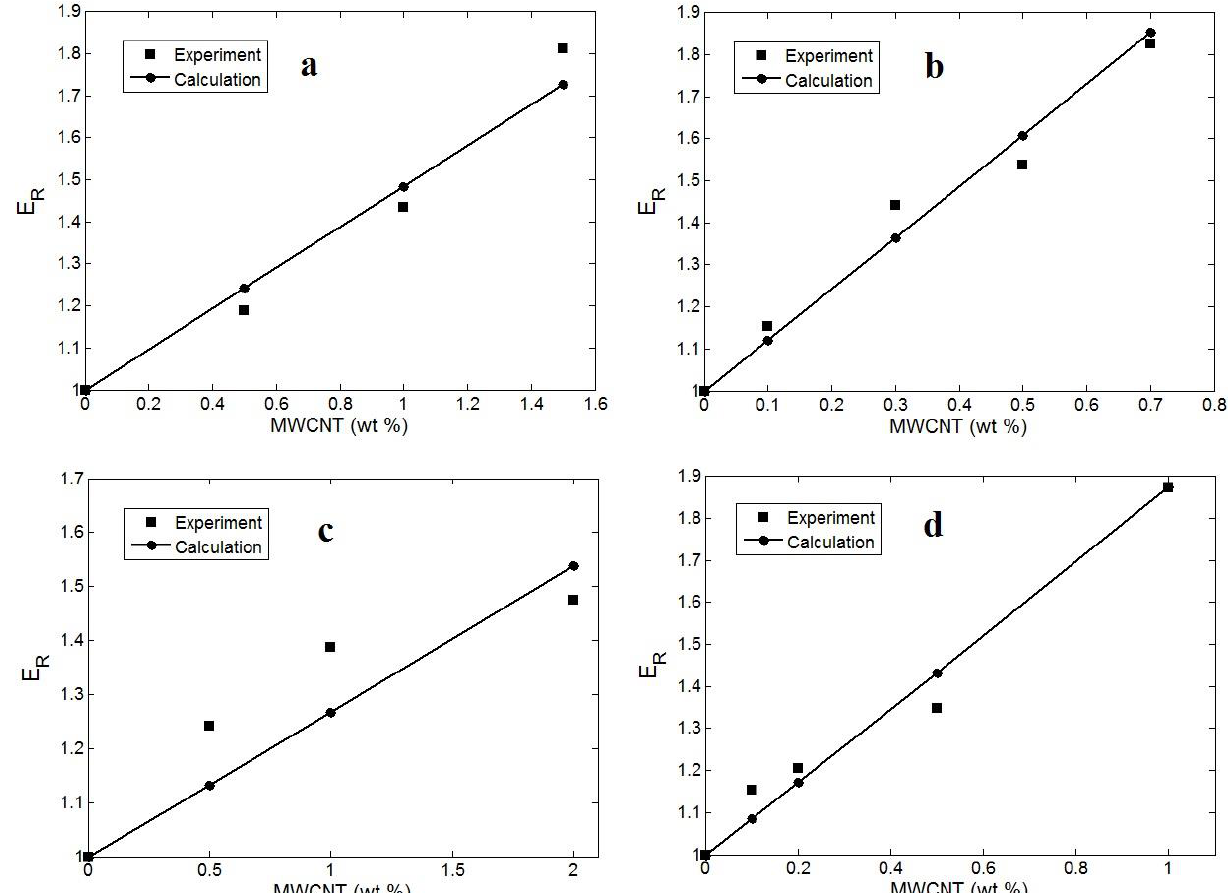
Figure 2. Tentative and theoretical ranks of relative modulus computed using the advanced model for ( a ) PA6/MWCNTs [41], ( b ) epoxy/MWCNTs [42], ( c ) phenolic/MWCNTs [43] and ( d ) PA6/MWCNTs-NH 2 [44] samples.